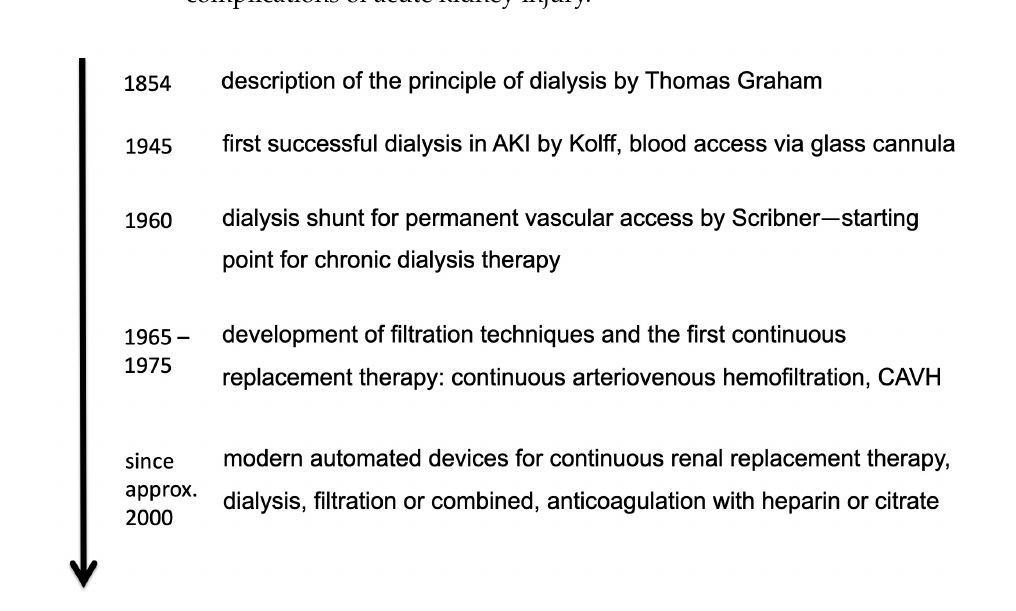
Figure 1. History of dialysis and development of renal replacement therapy.